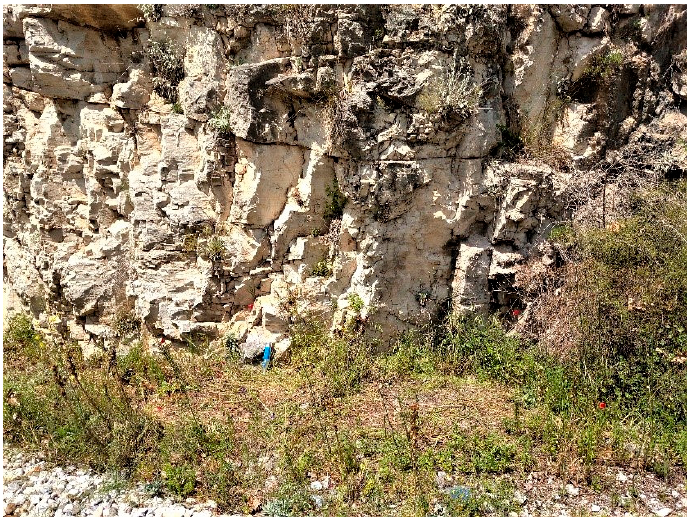
Figure 3. The investigated area during the field survey. The blue colored Schmidt hammer (length 28 cm) is indicated as a scale.